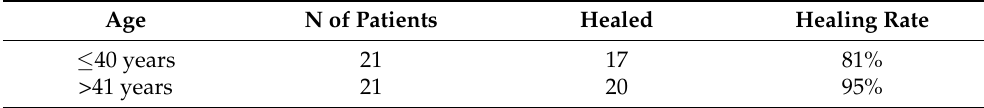
Table 4. Healing rate among patients younger or older than 40 years. Age N of